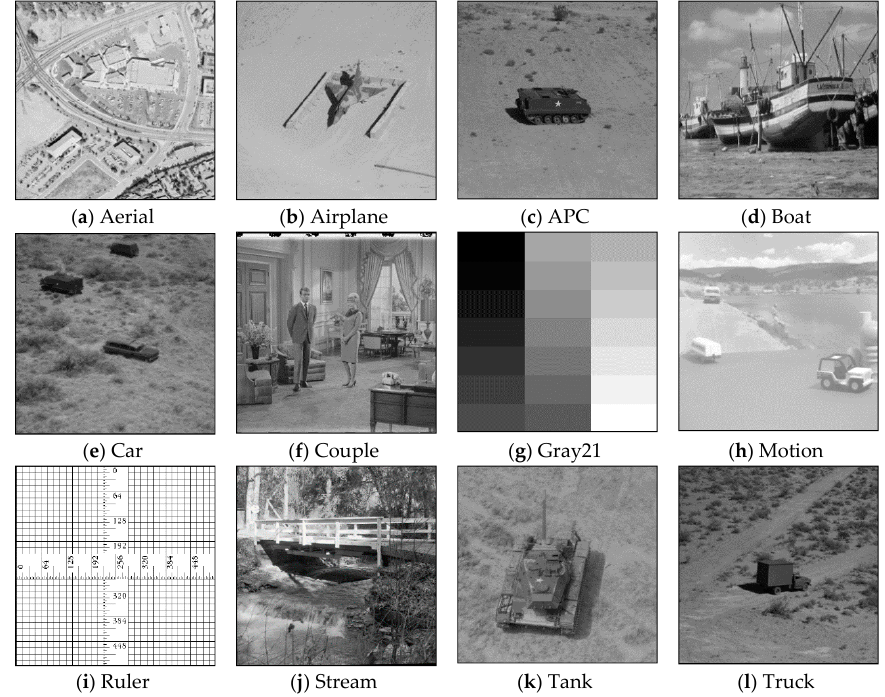
Figure 3. Cover images from USC-SIPI [24] dataset for experiments.